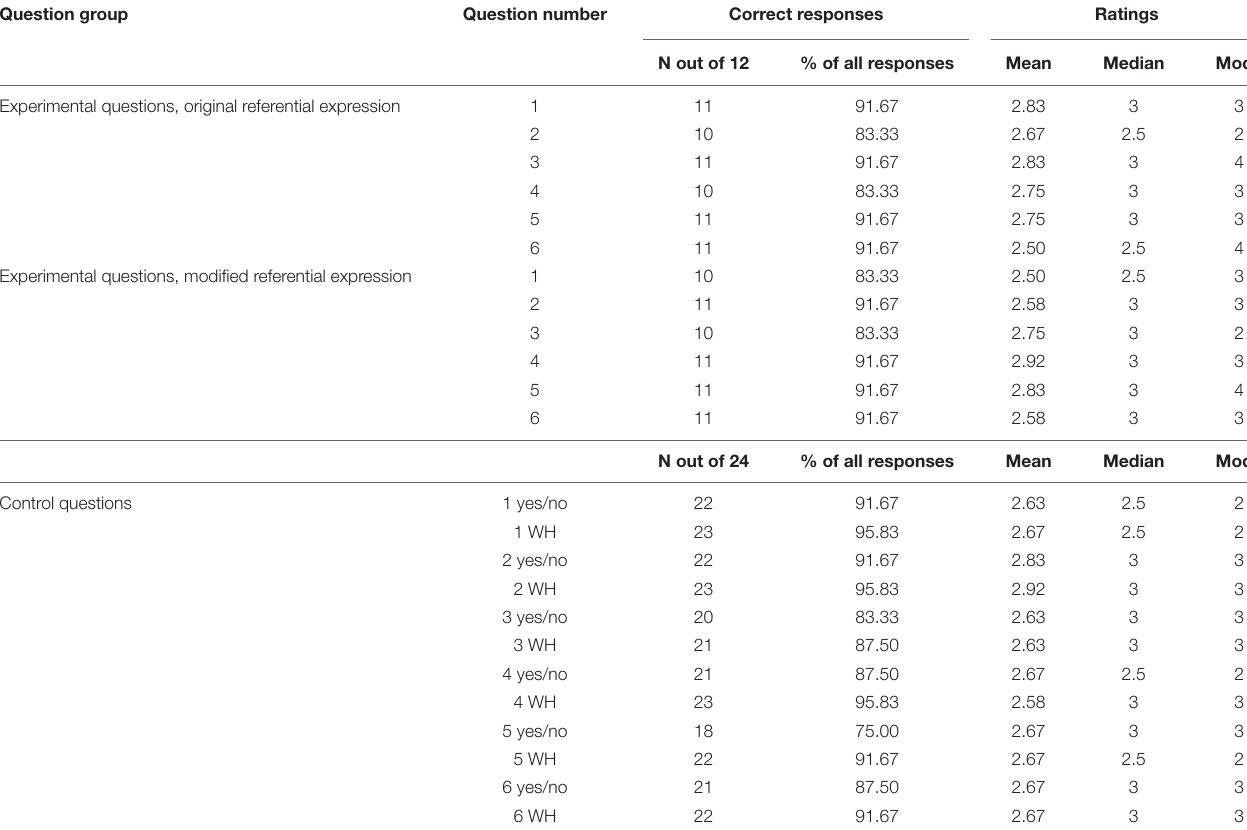
TABLE 11 | Numbers of correct responses to each question in the experiment and difficulty